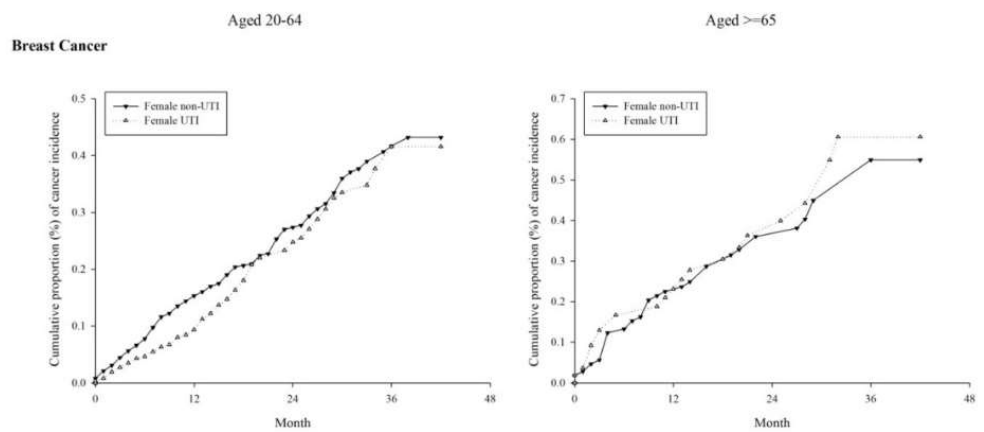
Figure A1. Kaplan-Meier curve for specific cancer risk in patients with/without UTI infection stratified Figure 1. Kaplan-Meier curve for specific cancer risk in patients with / without UTI infection by age stratified by age group.